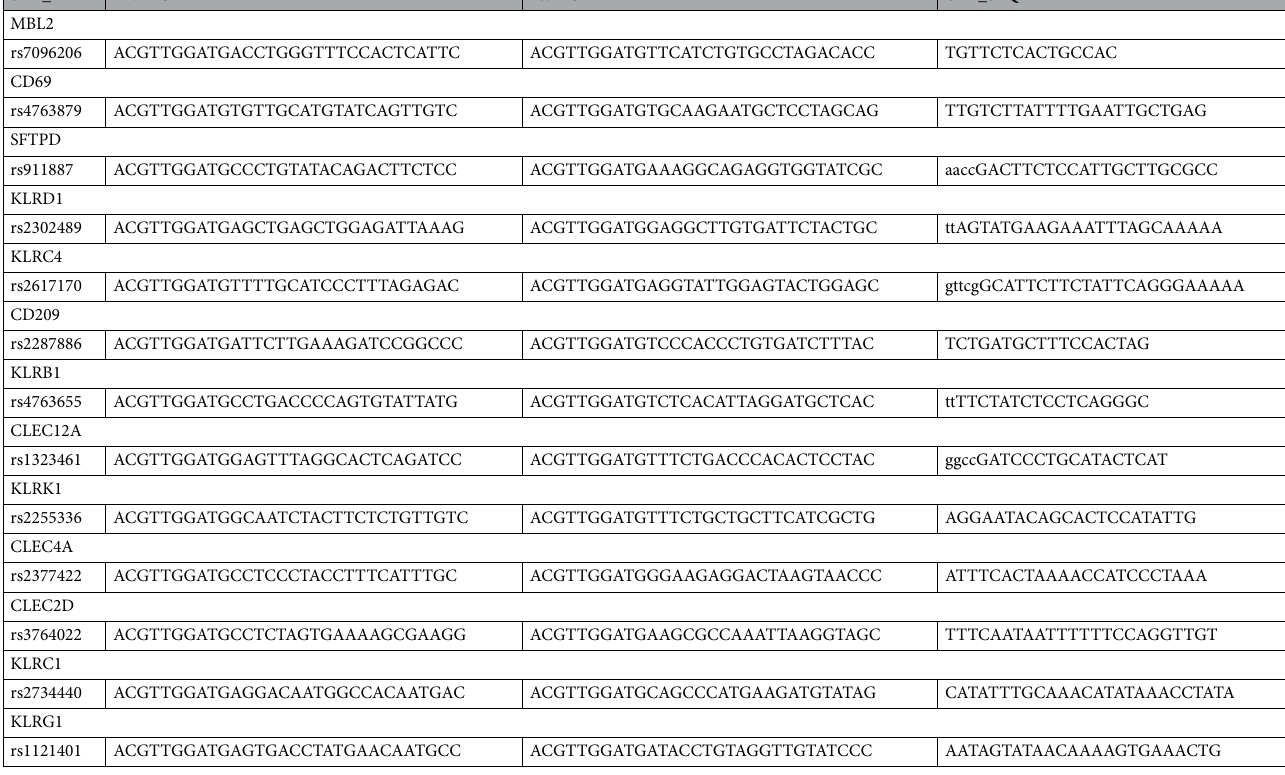
Table 3. Primers applied in the analysis of iPLEX Gold genotyping in the CLR related